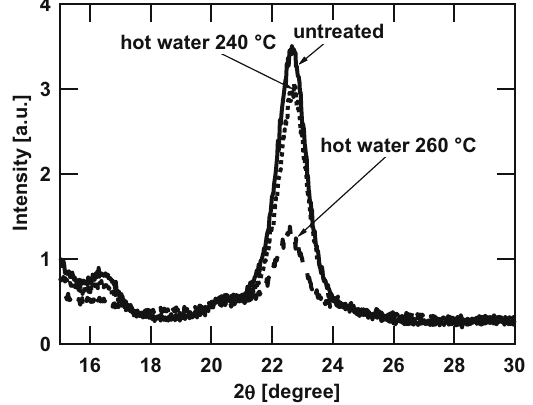
Figure 6: Changes in the crystallinity of cellulose through the hot water treatment.